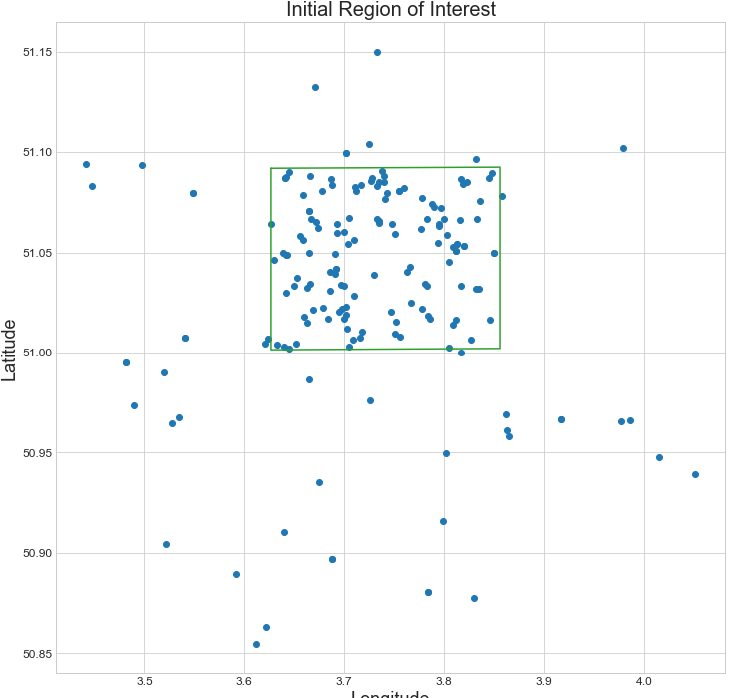
Figure 7. Coordinates of the geocoder matches that were located inside the initial region of interest. The ground truth geolocation of the map is shown in